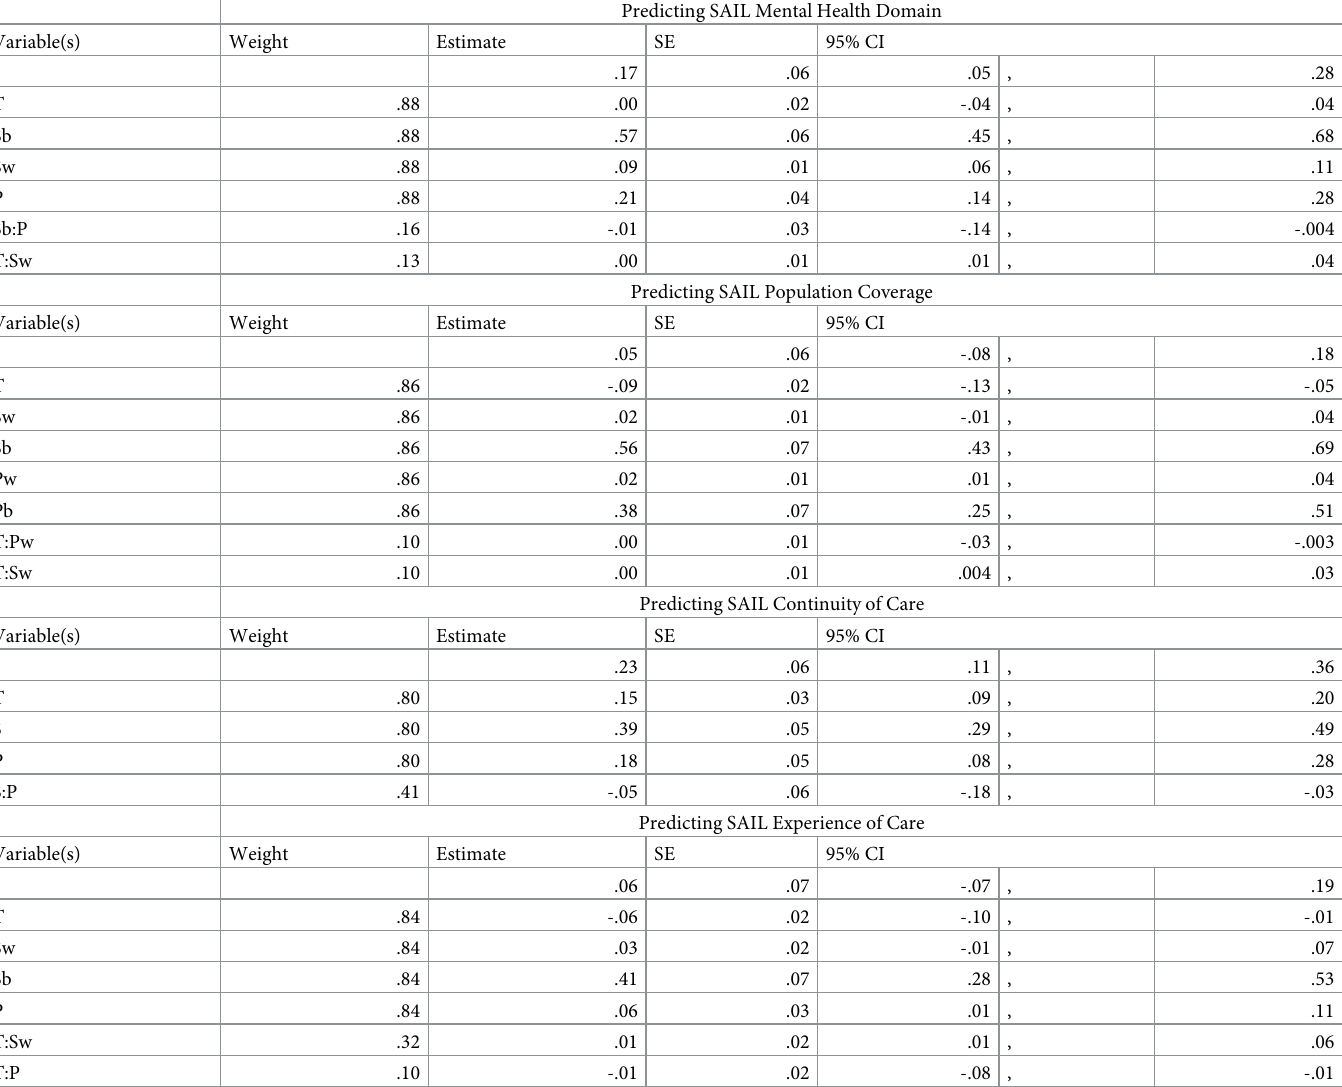
Table 3. Predictor sum of weights (ordered by), parameter estimates, SE and 95% confidence interval (CI) after full model averaging of the top models ( Δ AIC C < 4), separately assessing each SAIL mental health metric. Predicting SAIL Mental Health Domain